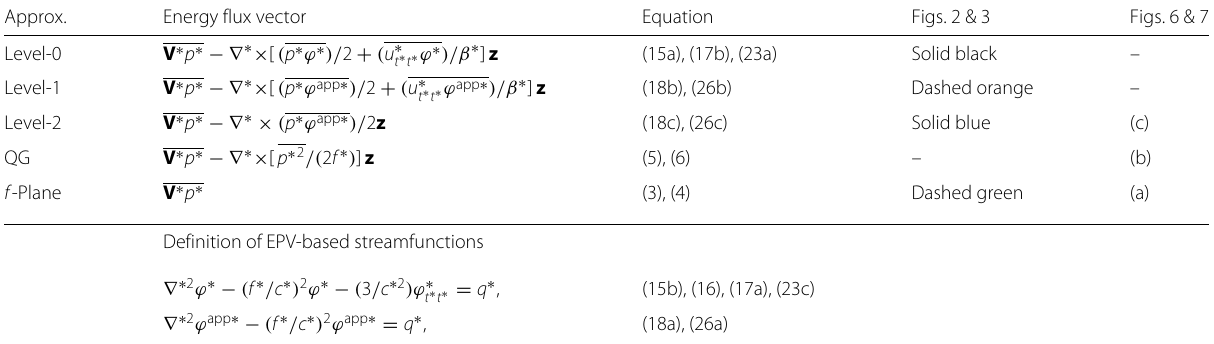
Table 3 List of energy flux vectors and EPV-based streamfunctions in dimensional form and their location in the text and figures